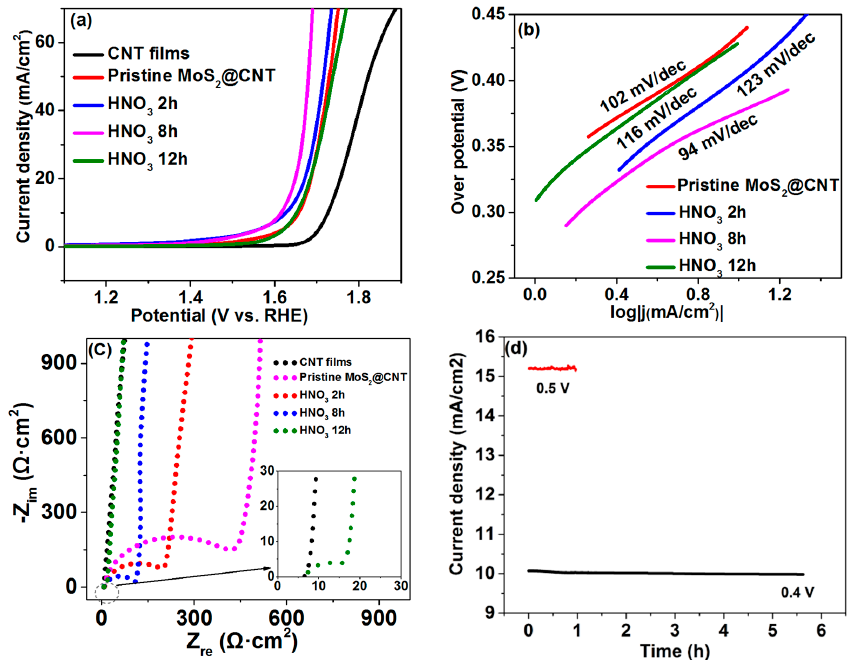
Figure 5. Electrochemical performances of different acid etching MoS 2 @CNT: ( a ) LSV curves of CNT film, pristine MoS 2 @CNT, MoS 2 @CNT treated with HNO 3 for 2 h, 8 h and 12 h; and ( b ) corresponding